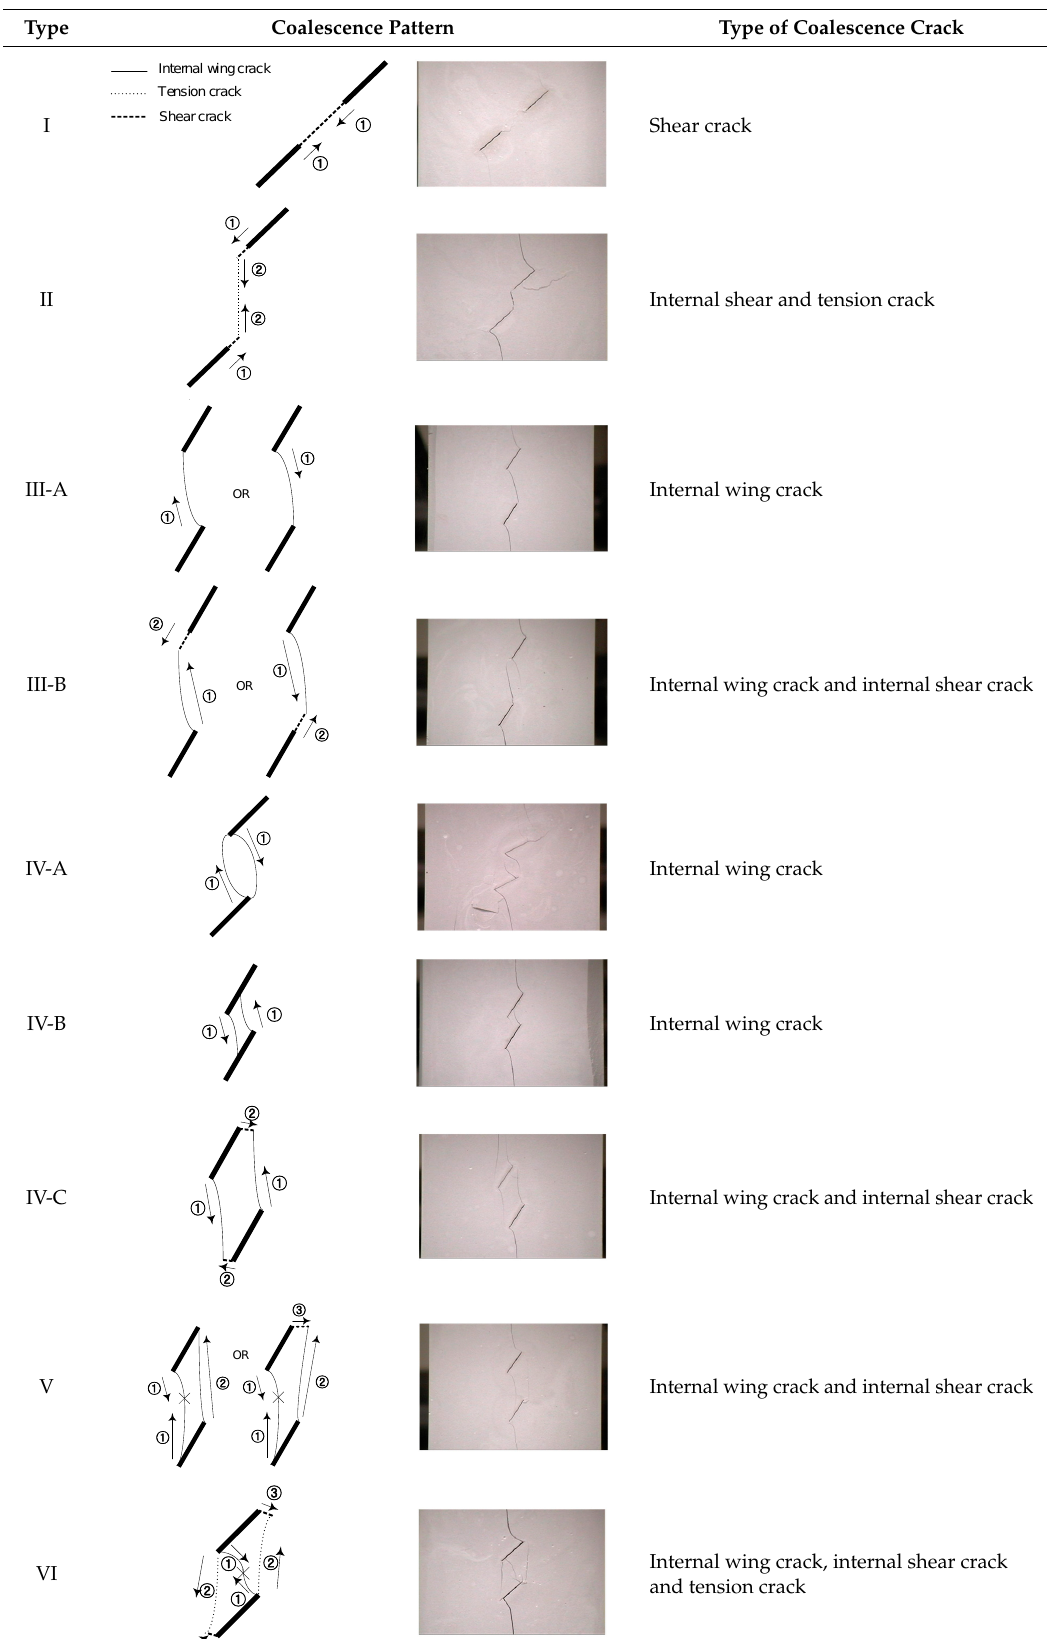
Table 4. Observed crack coalescence types.